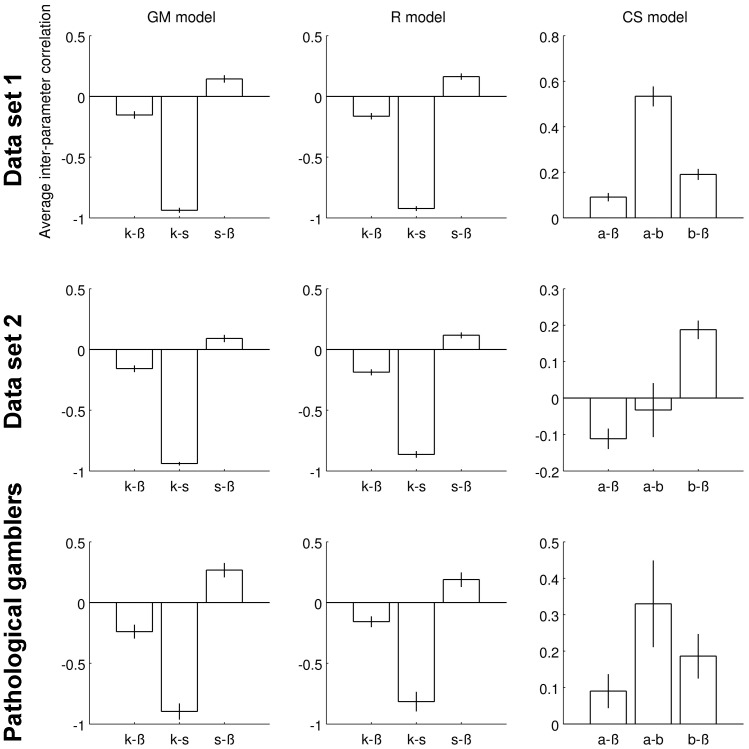
Within-subject inter-parameter correlations averaged across participants for each dataset.Note the strong inverse relationship between k and s in the R and GM models. In contrast, correlations between a and b in the CS model were much less pronounced. Correlations were computed based on a numerical approximation of the Hessian matrix (see methods section).